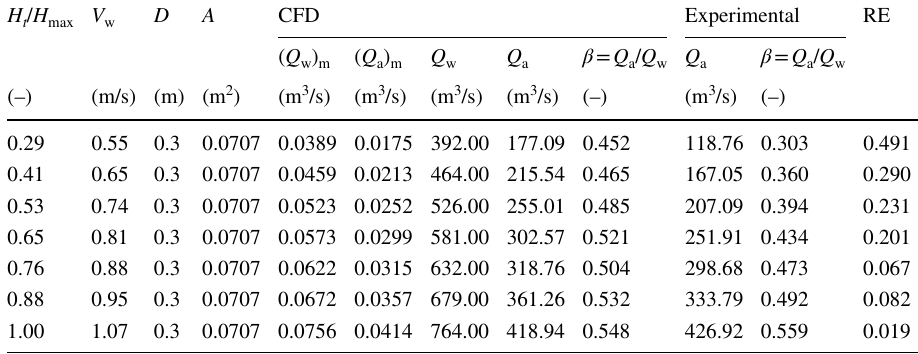
results for 1/40-scaled model